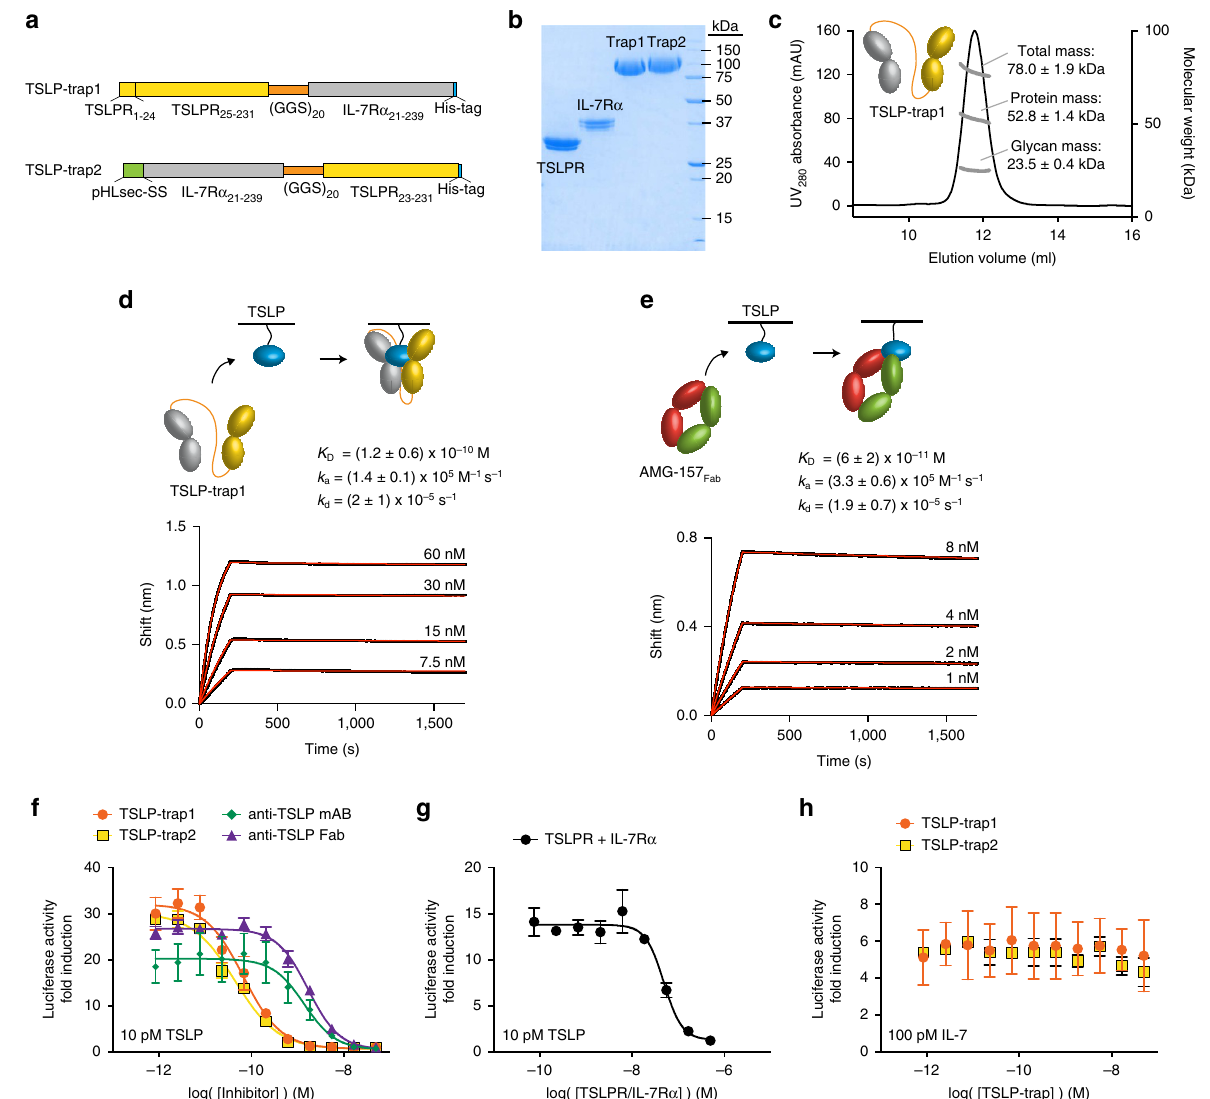
Figure 5 | TSLP cytokine traps potently antagonize TSLP signalling in vitro . ( a ) Design of TSLP-trap1 and TSLP-trap2 as fusion proteins between the IL-7R a and TSLPR ectodomains interconnected with a (Gly-Gly-Ser) 20 linker. ( b ) Coomassie-stained reducing SDS–PAGE gel of purified TSLPR, IL-7R a , TSLP-trap1 and TSLP-trap2. Molecular weights of protein standards are indicated. ( c ) SEC elution profile of TSLP-trap1 plotted as the ultraviolet absorbance at 280nm (left Y -axis) in function of elution volume. The total, protein and glycan molecular weight (right Y -axis) as determined by MALLS are reported as the number average molecular mass and s.d. ( d , e ) BLI data traces (black) and the fitted 1:1 binding model (red) are plotted as the spectral nanometre shift in function of time for the interaction of TSLP-trap1 ( d ) and anti-TSLPAMG-157 Fab fragment ( e ) with immobilized TSLP. The reported K D -, k a - and k d -values represent average values and their s.d. from three technical replicate experiments. 4nm of biotinylated TSLP was loaded for experiment ( d ) and 1nm of TSLP was loaded for experiment ( e ). ( f ) STAT5 activity induced by 10pM TSLP in function of increasing concentrations of inhibitors. The determined IC 50 - values were 67pM for TSLP-trap1; 44pM for TSLP-trap2; 1.4nM for AMG-157 and 1.7nM for AMG-157 Fab . ( g ) STAT5 activity induced by 10pM TSLP in the presence of increasing concentrations of an equimolar mixture of the soluble TSLPR and IL-7R a ectodomains. The determined IC 50 -value was 49nM. ( h ) STAT5 activity induced by 100pM IL-7 plotted in function of increasing concentrations of TSLP-traps. STAT5 activity in HEK293 cells is plotted as the luciferease activity fold induction. Each experiment was carried out in triplicate; data shown are averages, and error bars were calculated as